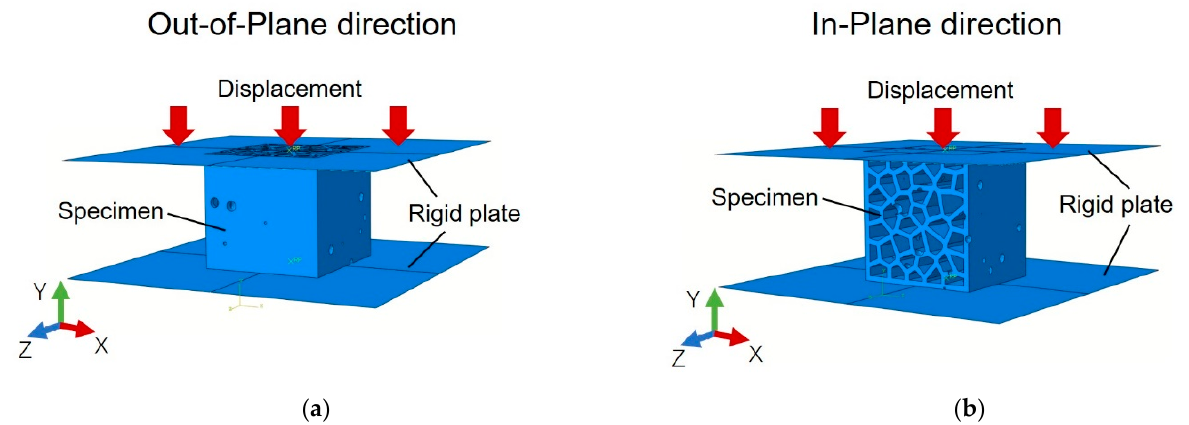
Figure 14. Loading setup in the simulation of ( a ) the out-of-plane direction and ( b ) the in-plane direction.